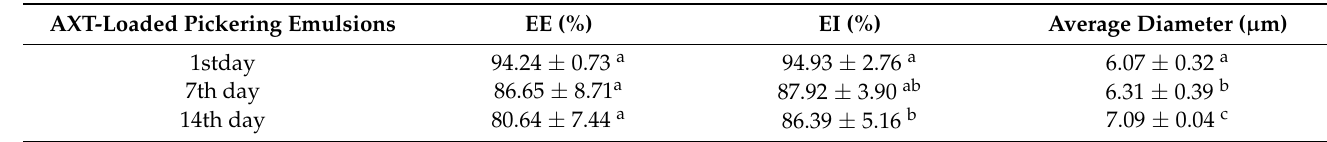
Table 1. EE%, EI%, and the average diameter of AXT-loaded Pickering emulsions stored for 1 day, 7 days, and 14